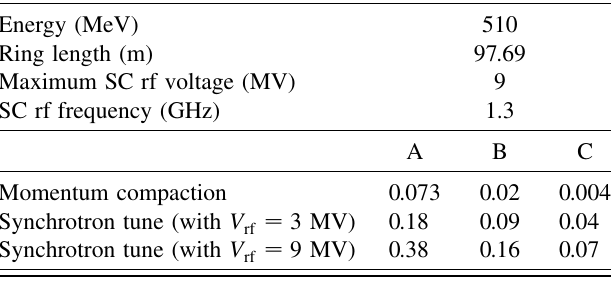
TABLE I. Main parameters of the cases A, B, and C.